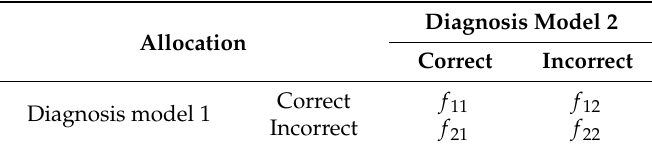
Table 2. Assessment of the statistical significance of the difference between two diagnosis models using McNemar’s Test 1 .